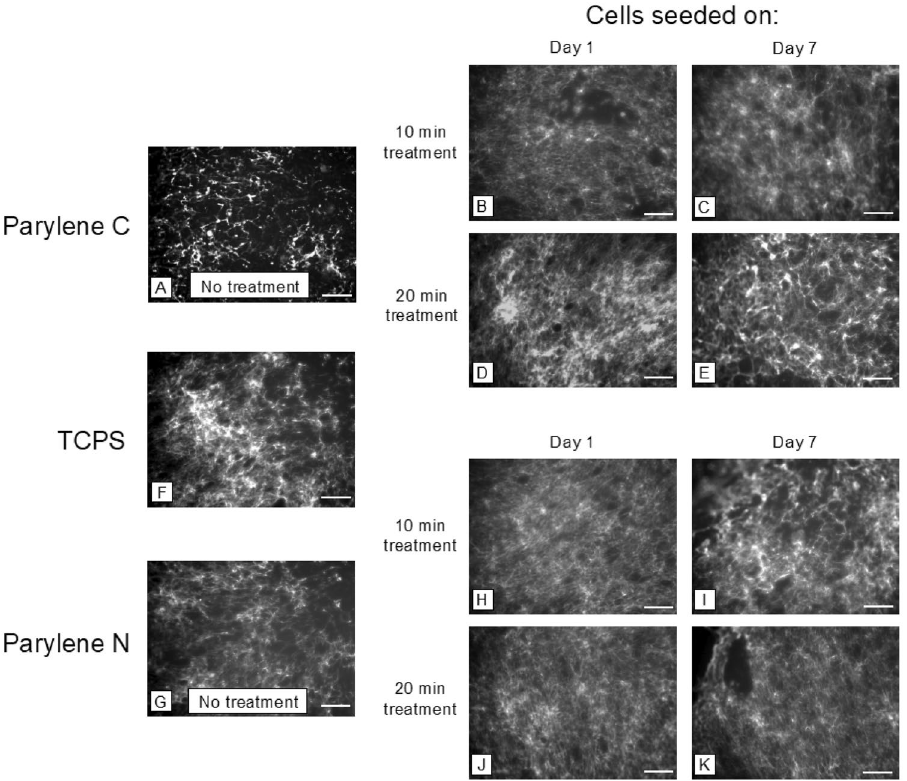
Figure 3. Representative images of fibronectin fibrillogenesis by vascular endothelial cells on ( A–E ) Parylene C membranes, ( F ) TCPS, and ( G–K ) Parylene N membranes. Scale bar = 100 μm in all